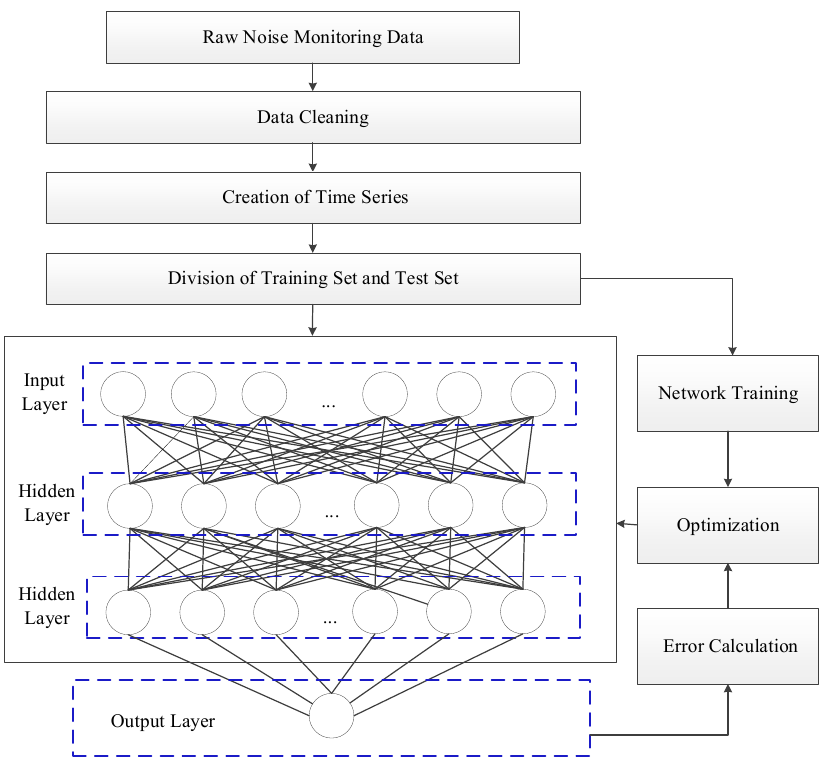
Figure 3. Overall framework of the LSTM model.